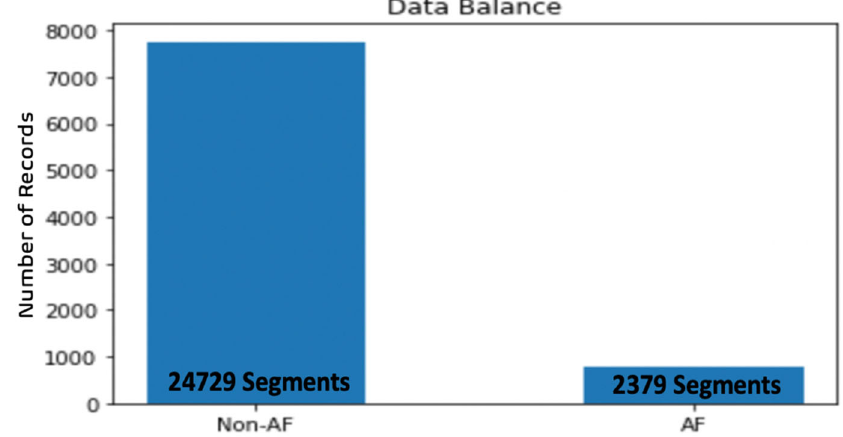
Figure 6. Distribution of segments of the two classes after segmentation. Figure 6 . Distribution of segments of the two classes after segmentation. Table 5. Comparison of the effects of different balancing techniques on the model performance.